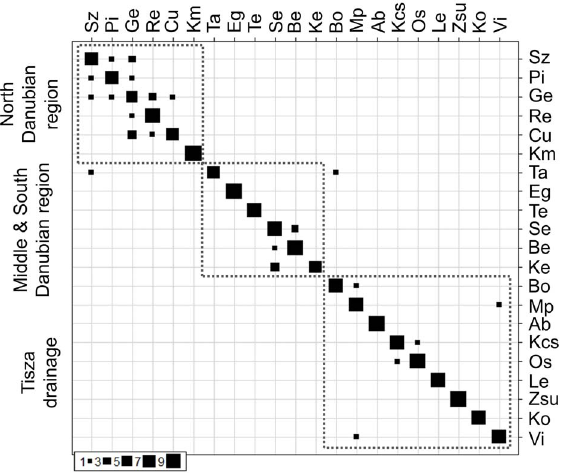
Figure 5. Plots of cross-validation tables for AFLP data based on DAPC. Correctly classified individuals are placed on the diagonal. The square size equals the number of individuals of posterior group assignment based on posterior probabilities. Rows correspond to actual sites (a priori), while columns correspond to inferred sites (posteriori). Squares with broken lines show regional detachments of populations.